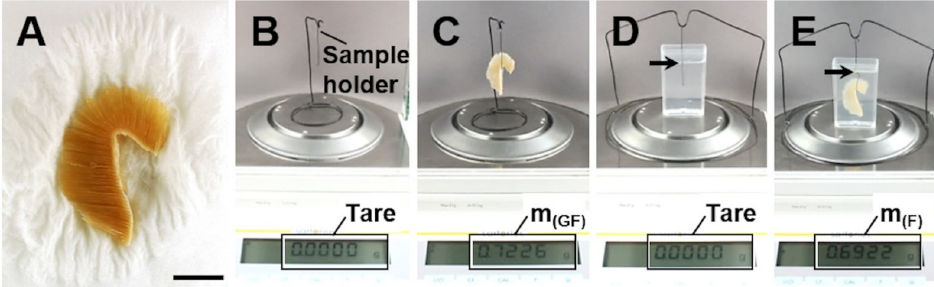
Fig 7. Determination of gill filament density and sample volume, using the submersion method (Archimedes‘principle). A. Fixed gill after excision of the gill arch, briefly blotted dry on lab-paper towel to remove adhering liquid. B. Scale tared to the weight of the sample holder. C. Measurement of the GF sample weight (m (GF) ). D. Scale tared to the weight of a container filled with physiological saline or fixative of known density and the submerged sample holder. Note that the sample holder is not placed on the scale sensor and does not have contact to the bottom or the walls of the container. The arrow indicates the position up to which the sample holder is submerged into the liquid. E. The sample is attached to the sample holder and completely submerged into the liquid up to the marked position on the sample holder. Note that the sample does not have contact to the bottom or the walls of the container. The weight of the fluid displaced by the GF sample (m (F) ) is recorded. The sample volume is calculated from the sample weight (m (GF) ) and the GF density ( ρ (GF) ), using Eq 1